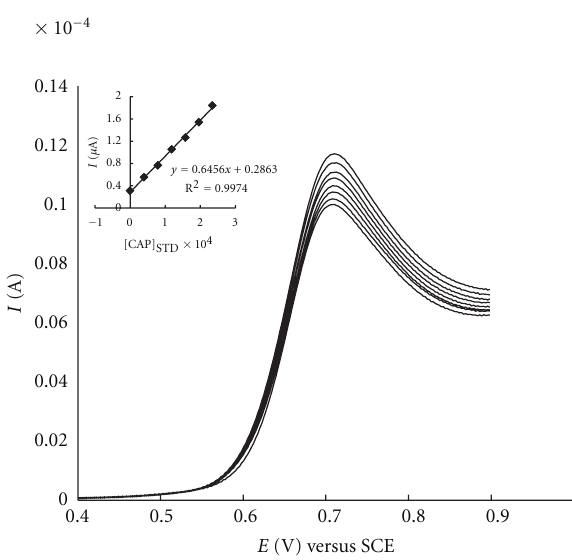
Figure 7: Linear sweep voltammograms and standard addition plot (inset) for the determination of CAP in blood serum sample. The concentration of spiked CAP was 5.0 × 10 − 5 M, and the peak current of CPZ is subtracted from all peak currents in the presence of CAP. Experimental conditions are as Figure 6.